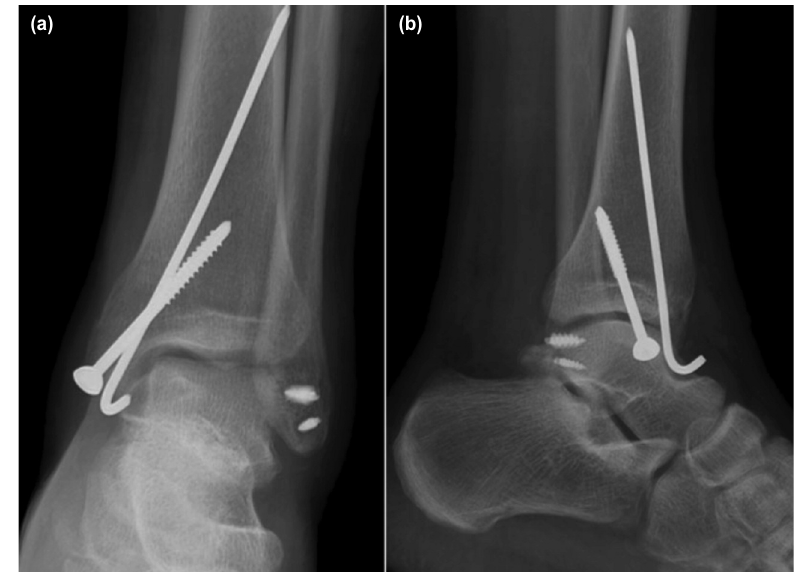
(a) Anteroposterior and (b) Lateral ankle radiographs of the patient six months after the Fig. 3: